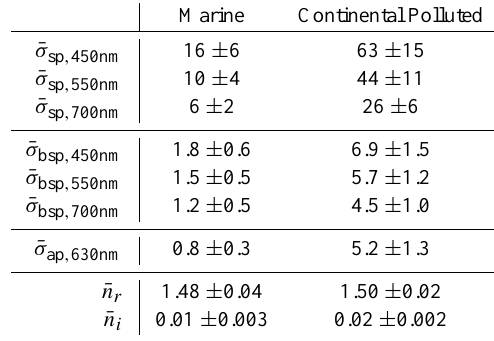
Table 5. Mean values of measured total scatter and absorption co- efficients (Mm − 1 ) and retrieved refractive index, divided into ma- rine air masses and continentally polluted air masses.